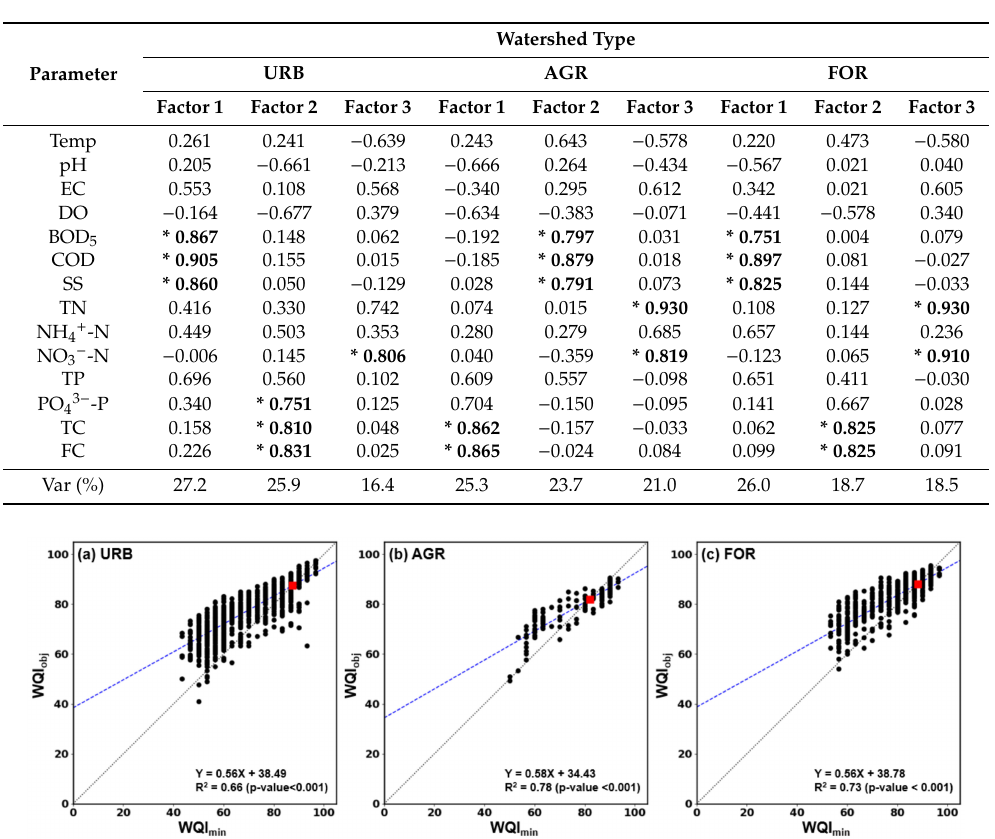
Table 3. Factor loadings for 14 water quality parameters for watersheds with urban-dominated (URB), agricultural-dominated (AGR), and forest-dominated (FOR) land-cover. Asterisks (*) indicate a factor loading greater than 0.75 or the highest factor loading in the factor. Var (%) represents the explained variance of total variance for each factor.